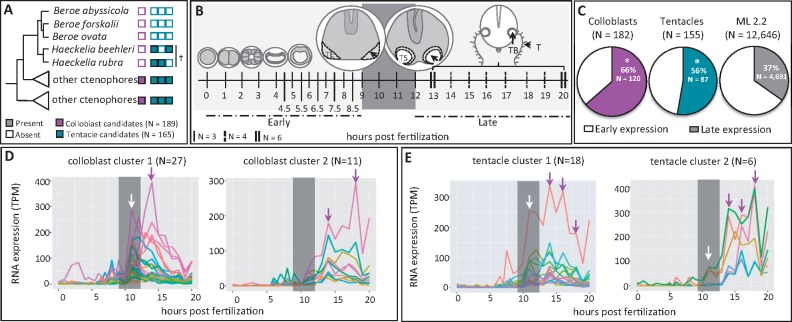
Identifying colloblast and tentacle candidate genes. (A) Summarized 18S tree. Colloblast candidates (N = 189) were present in ≥70% of the sampled taxa but absent from Beroe and Haeckelia (magenta boxes). Tentacle candidates (N = 165) were present ≥70% of the sampled taxa, including at least one species of Haeckelia (dagger), but were absent from Beroe (teal boxes). (B) Developmental transcriptome sampling for Mnemiopsis leidyi. Early cleavage occurs during the first 8 h post fertilization (hpf). A thickened tentacle epithelium (TE) is visible at 9 hpf and invagination of the epithelium to form the tentacle sheath (TS) is complete by 12 hpf. Larval tentacles (T) grow continuously from the tentacle bulb (TB). (C) Candidate data sets are enriched for genes expressed during tentacle morphogenesis, relative to gene models from M. leidyi (ML2.2) (P < 0.0001 for both). (D, E) The two largest clusters of gene expression profiles identified from candidate genes; colored lines represent different genes. Grey bars denote the 9–12 hpf window highlighted in panel B. White arrows indicate peaks in expression during tentacle bulb invagination, magenta arrows indicate peaks during tentacle morphogenesis. TPM—transcripts per million mapped reads.